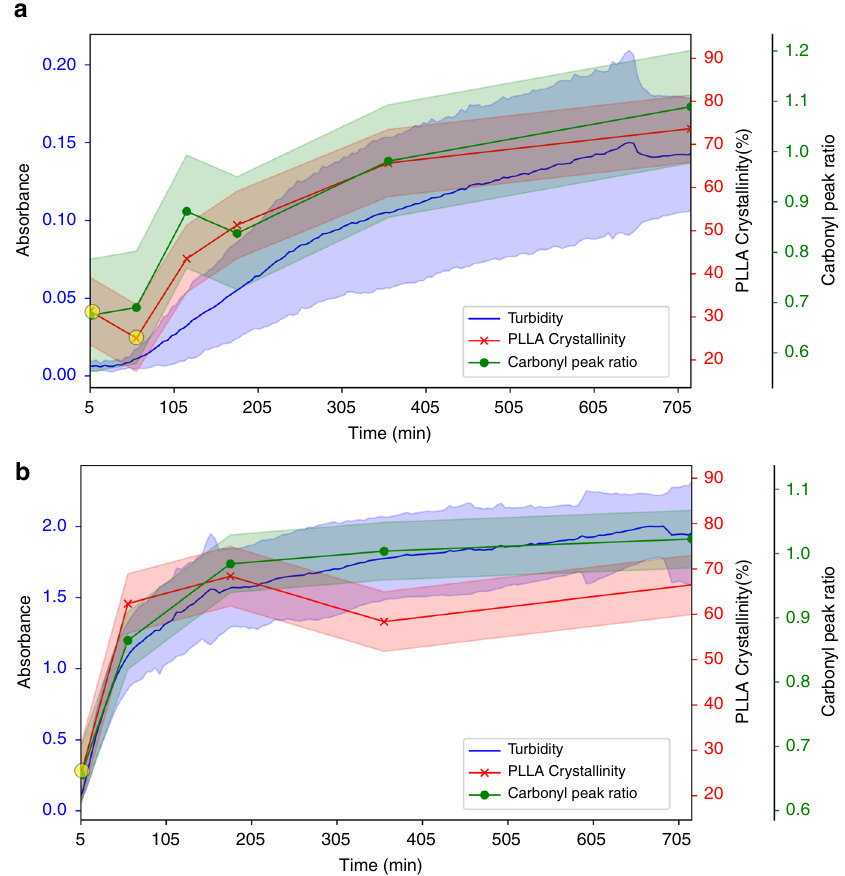
Fig. 6 ROPI-CDSA Kinetics. Composite graphs showing the change in turbidity (measured at 600 nm), % crystallinity of PLLA block, and carbonyl peak ratio for a PLLA 45 - b -PEG 45 (10% solids w/w 9 ) and b PLLA 90 - b -PEG 45 (10% solids w/w 15 ). The standard error of 3 runs is plotted for turbidity measurements and a calculated error is plotted for crystallinity and carbonyl peak ratio values, see Supplementary information for more details. For the PLLA crystallinity (%) data, early time point metastable crystalline precursors are highlighted with a yellow circle. The data show that the self-assembly kinetics are coincident with the crystallinity kinetics.